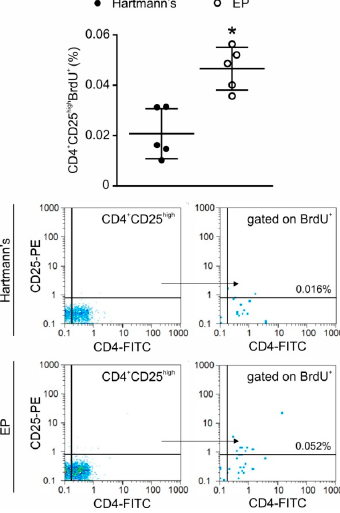
Figure 6. Treg proliferation after intraperitoneal EP application. EP was administered twice a day for two days, while BrdU was applied intraperitoneally 24 h before ex vivo analysis. Treg (CD4 + CD25 high ) proliferation was determined by flow cytometry. Representative dot plots and gating strategy are shown below the graph. * p < 0.05 represents the significant difference between EP-treated mice compared to vehicle-treated mice.